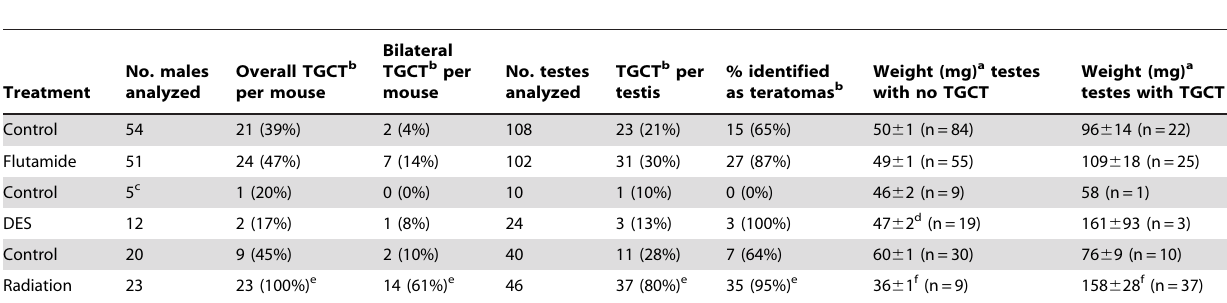
Table 2. Testicular germ cell tumor (TGCT) incidence and related characterization in 129.MOLF-L1 congenic mice with or without in utero flutamide, DES, or radiation